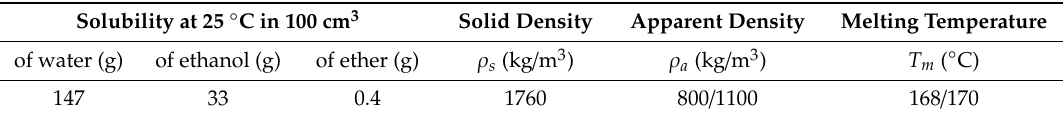
Table 2. Properties of the tartaric acid used in the research [35].